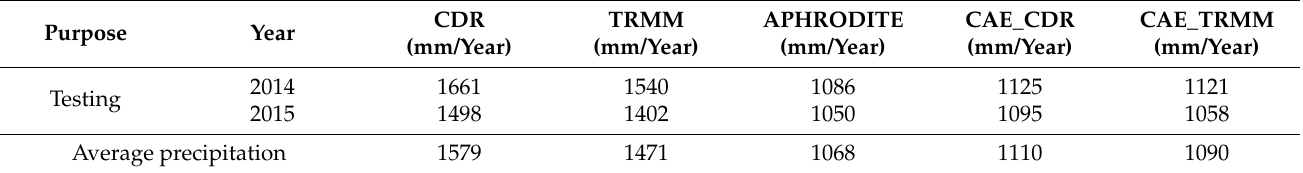
Figure 4. Correlation of average monthly rainfall of data sources for the whole MRB. Table 1. Annual rainfall of data sources for the whole MRB.